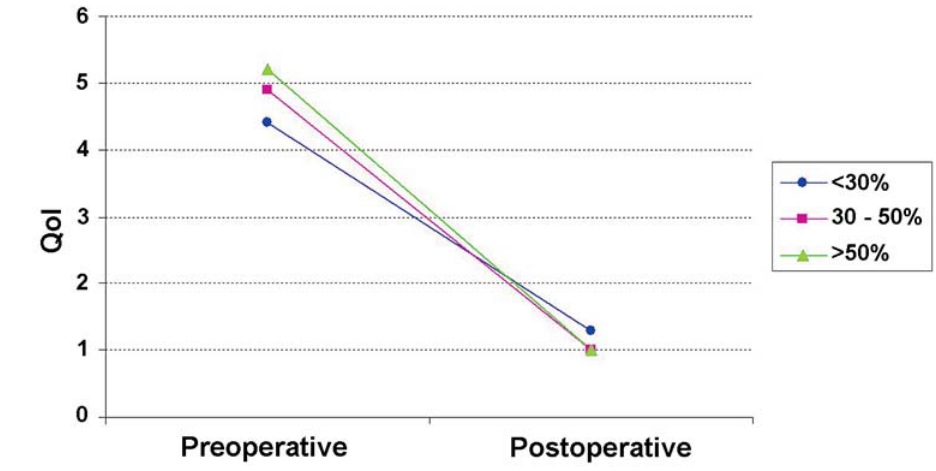
Figure 1 – Variation in quality of life (QoL) according to percentage of resected